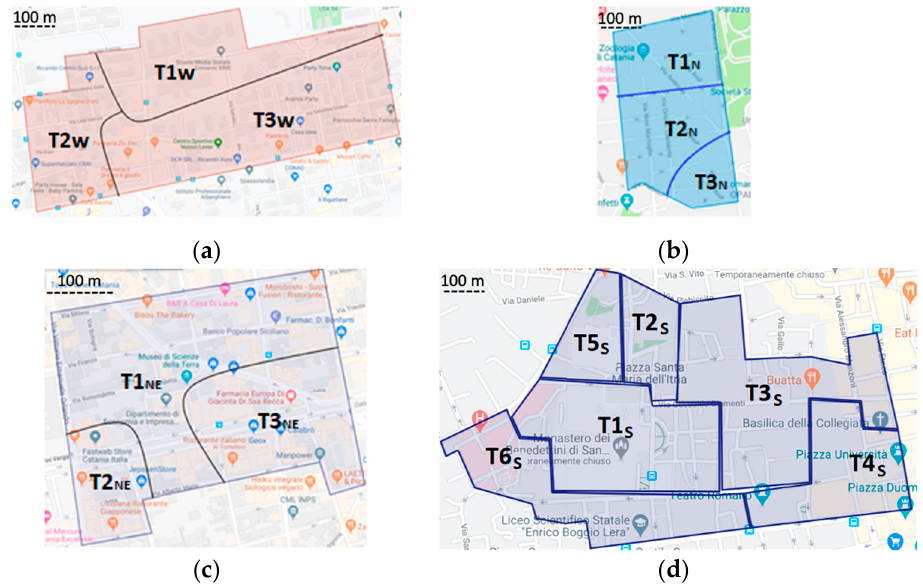
Figure 4. The investigated areas: ( a ) west area; ( b ) northeast area; ( c ) north Old Town; and ( d ) south Old Town.